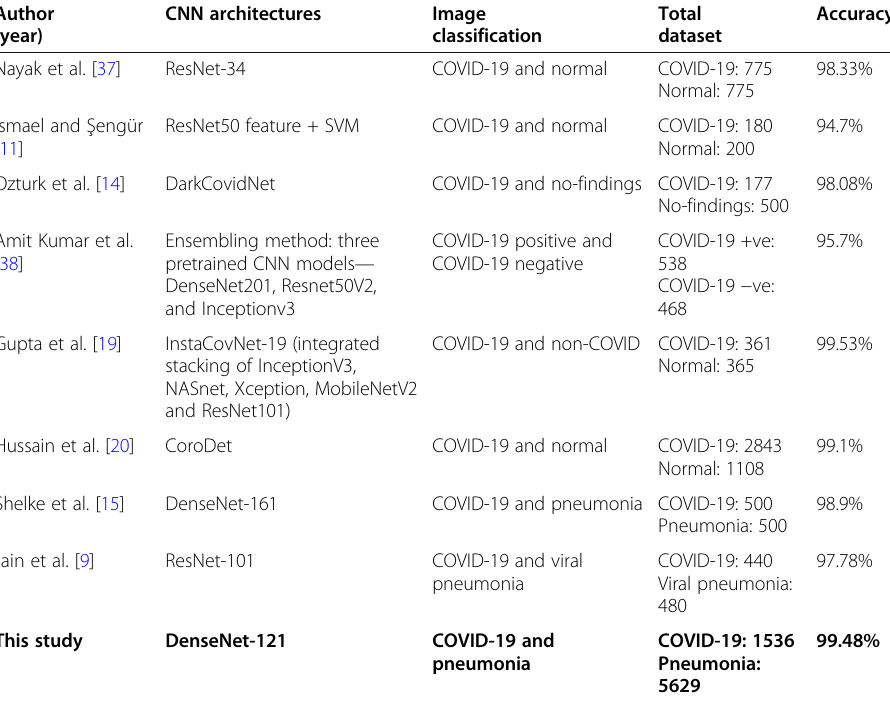
Table 6 Comparison with other related work that performed binary classification on CXR images Author